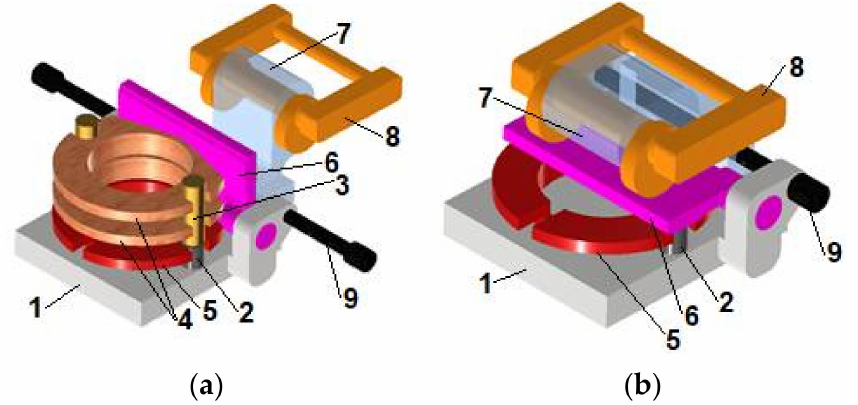
Figure 4. Scheme of milling chuck. ( a ) In open state—during supply of the bobbin case to the milling chuck; ( b ) In close state—directly before milling the groove in the bobbin case. 1—milling check support, 2—locating pin, 3—wire guides, 4—series of bobbin case delivered from a supply bin on the production line (not presented here), 5—machined bobbin case, 6—swivel arm, 7—lever, 8—eccentric, and 9—locking